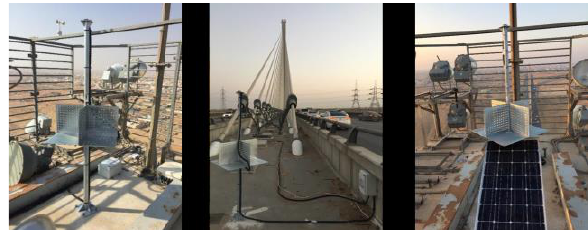
Figure 5. Co-located CRs and GNSS antennas installed on the bridge